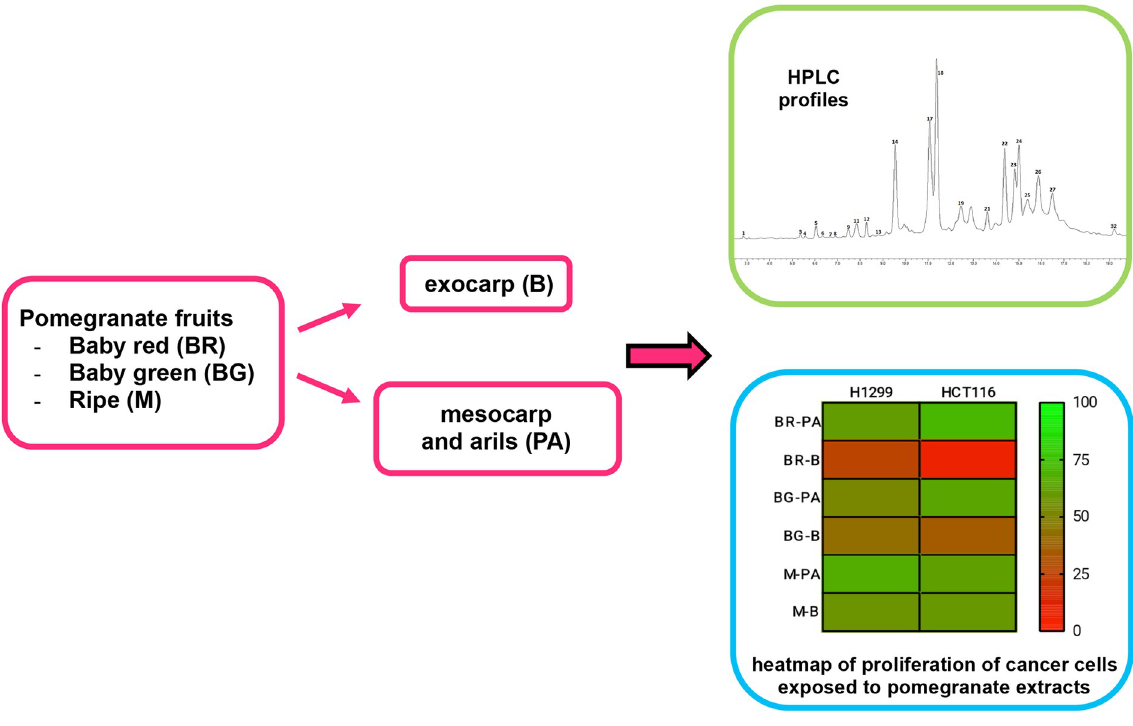
Fig 1. Workflow scheme of the studies